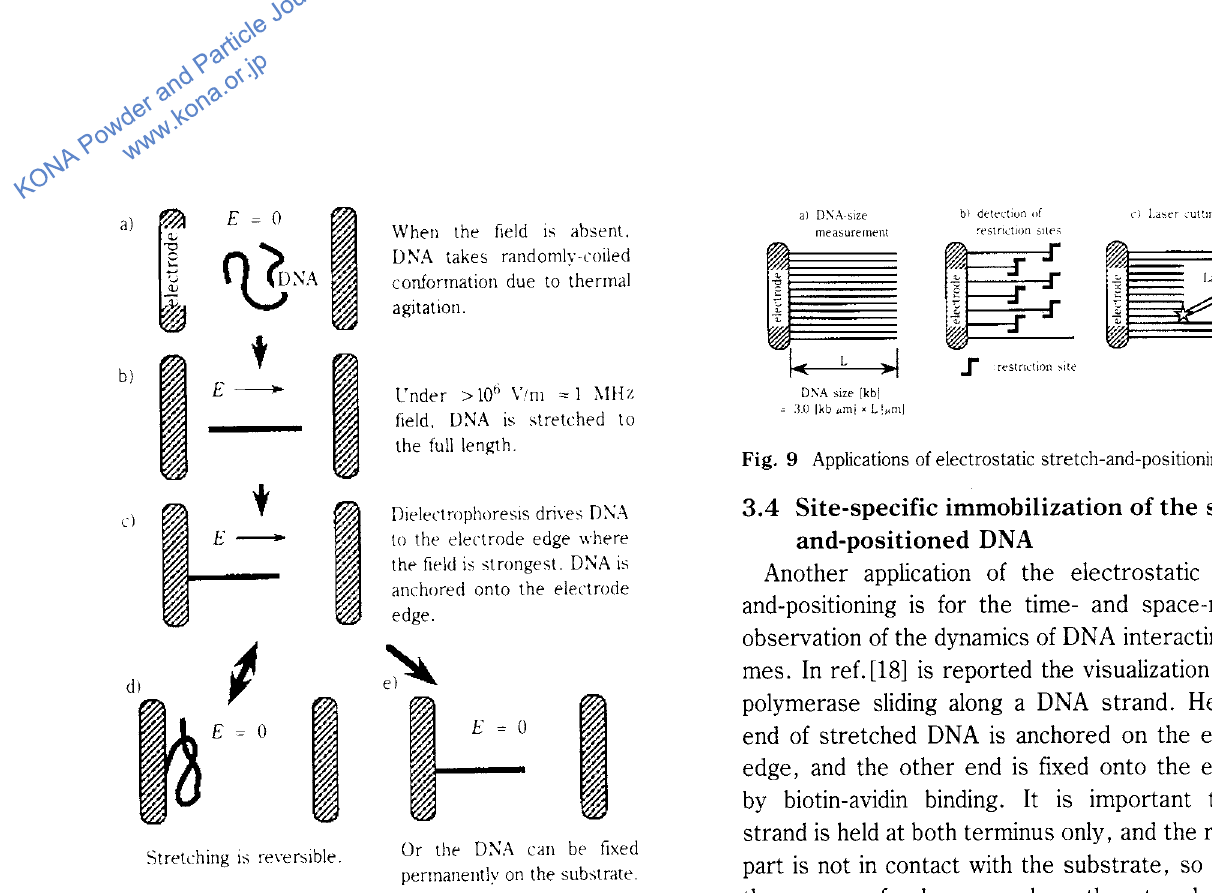
Fig. 8 The electrostatic stretch-and-positioning of DNA positioning of DNA'' [17]. The stretching is reversi ble, and the DNA springs back to random-coil con formation when the field is removed, still one end securely anchored on the electrode (Figure 8 d).